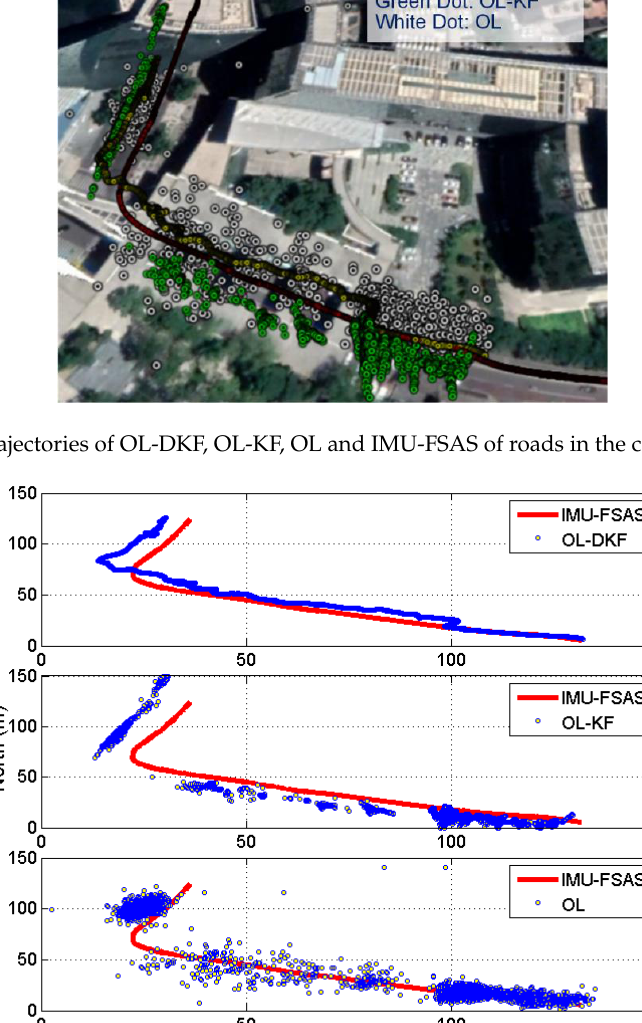
Figure 29. Position plot of OL-DKF, OL-KF and OL against IMU-FSAS of the roads in the city canyon test.